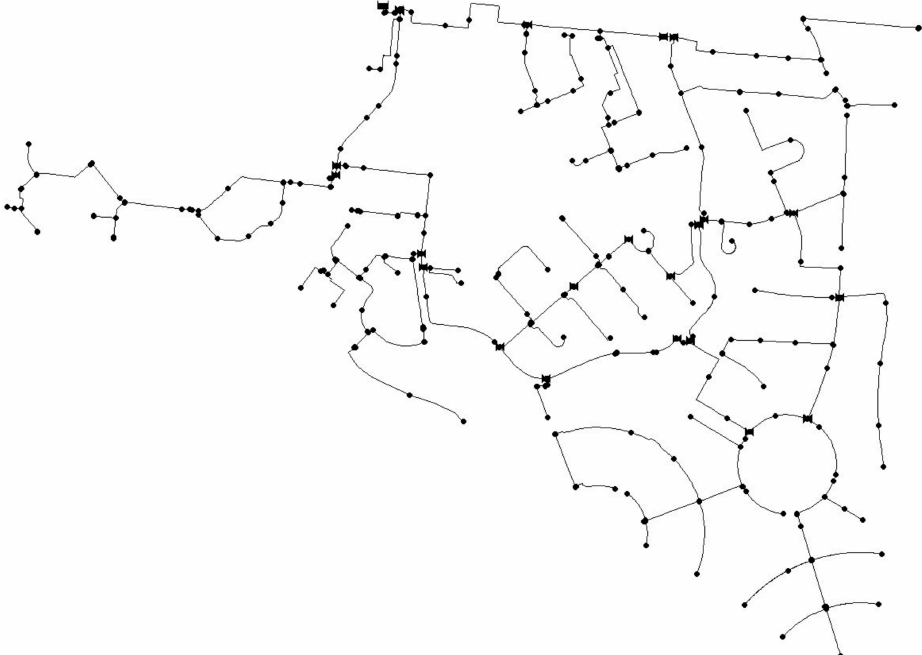
Figure 1. Network model for the WDN serving part of city S in the Netherlands. This network model consists of 497 nodes, 474 pipes and one reservoir. Valves are also depicted in the figure.